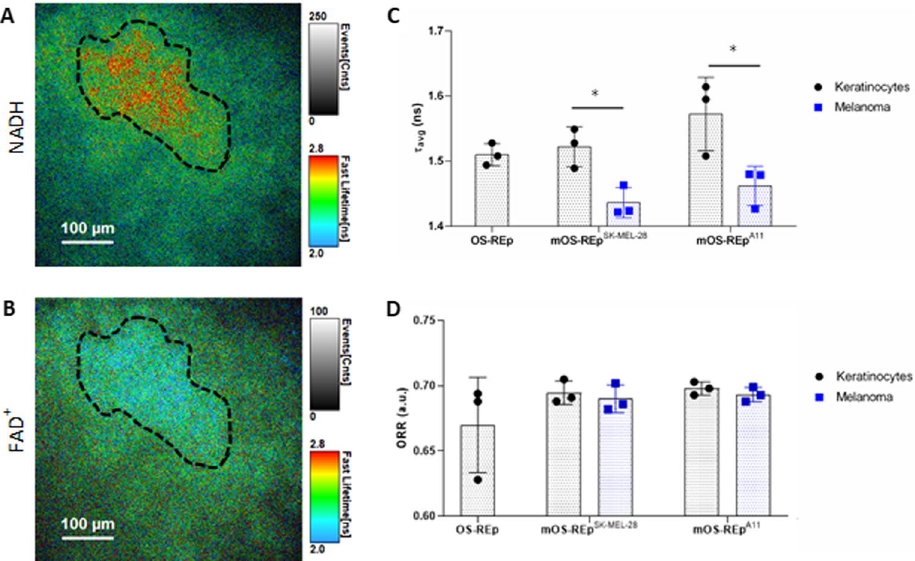
Figure 2:. 2P-FLIM of NAD(P)H and FAD + analysis. ( A , B ) Representative NAD(P)H and FAD + images of mOS-REp A11 with keratinocytes area highlighted (black dashes). ( C , D ) Calculated average fluorescence lifetimes (τ avg ) of NAD(P)H and optical redox ratio (ORR) for OS-REp, mOS-REp SK-MEL-28 , mOS-REp A11 . A reduction of τ avg is related with an increase in glycolysis while a reduction of ORR is associated with higher metabolic